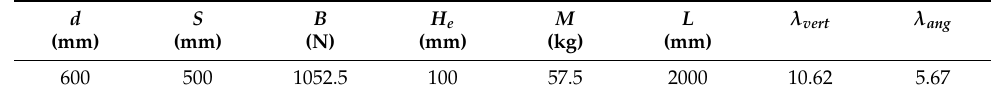
Table 1. Summary on the buoy unit sizing.